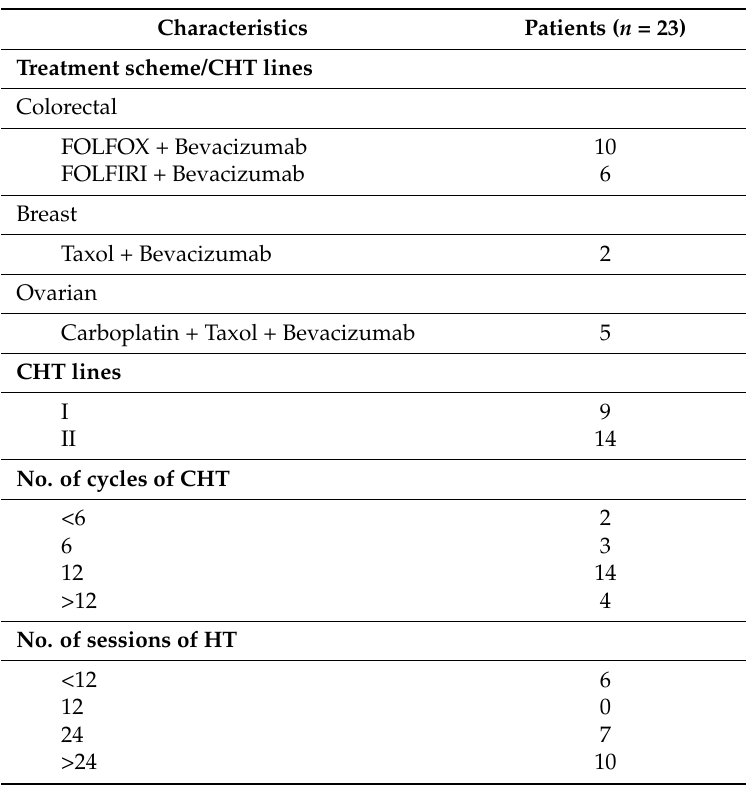
Table 2. Patients’ treatment characteristics. CHT, chemotherapy; FOLFOX, folinic acid (leucovorin), 5-fluorouracil, oxaliplatin; FOLFIRI, folinic acid (leucovorin), 5-fluorouracil, irinotecan; HT,